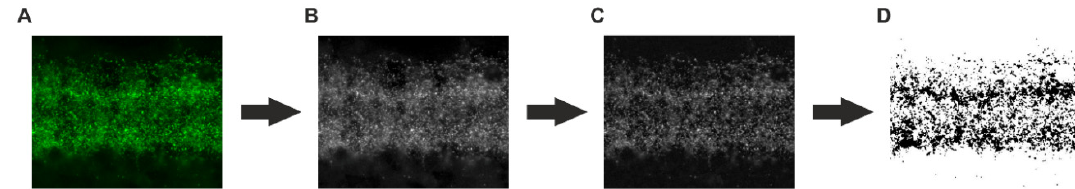
Figure A1. Image processing by ImageJ software using the example of an anti-gephyrin-stained retina. ( A ) Raw image files were added to the ImageJ software. ( B ) Pictures were converted into 32-bit greyscale. ( C ) A previously defined appropriate background was subtracted. ( D ) Then, images were converted into black and white and an upper and lower threshold was set. Suitable thresholds were defined when the black-and-white picture matched the original one.